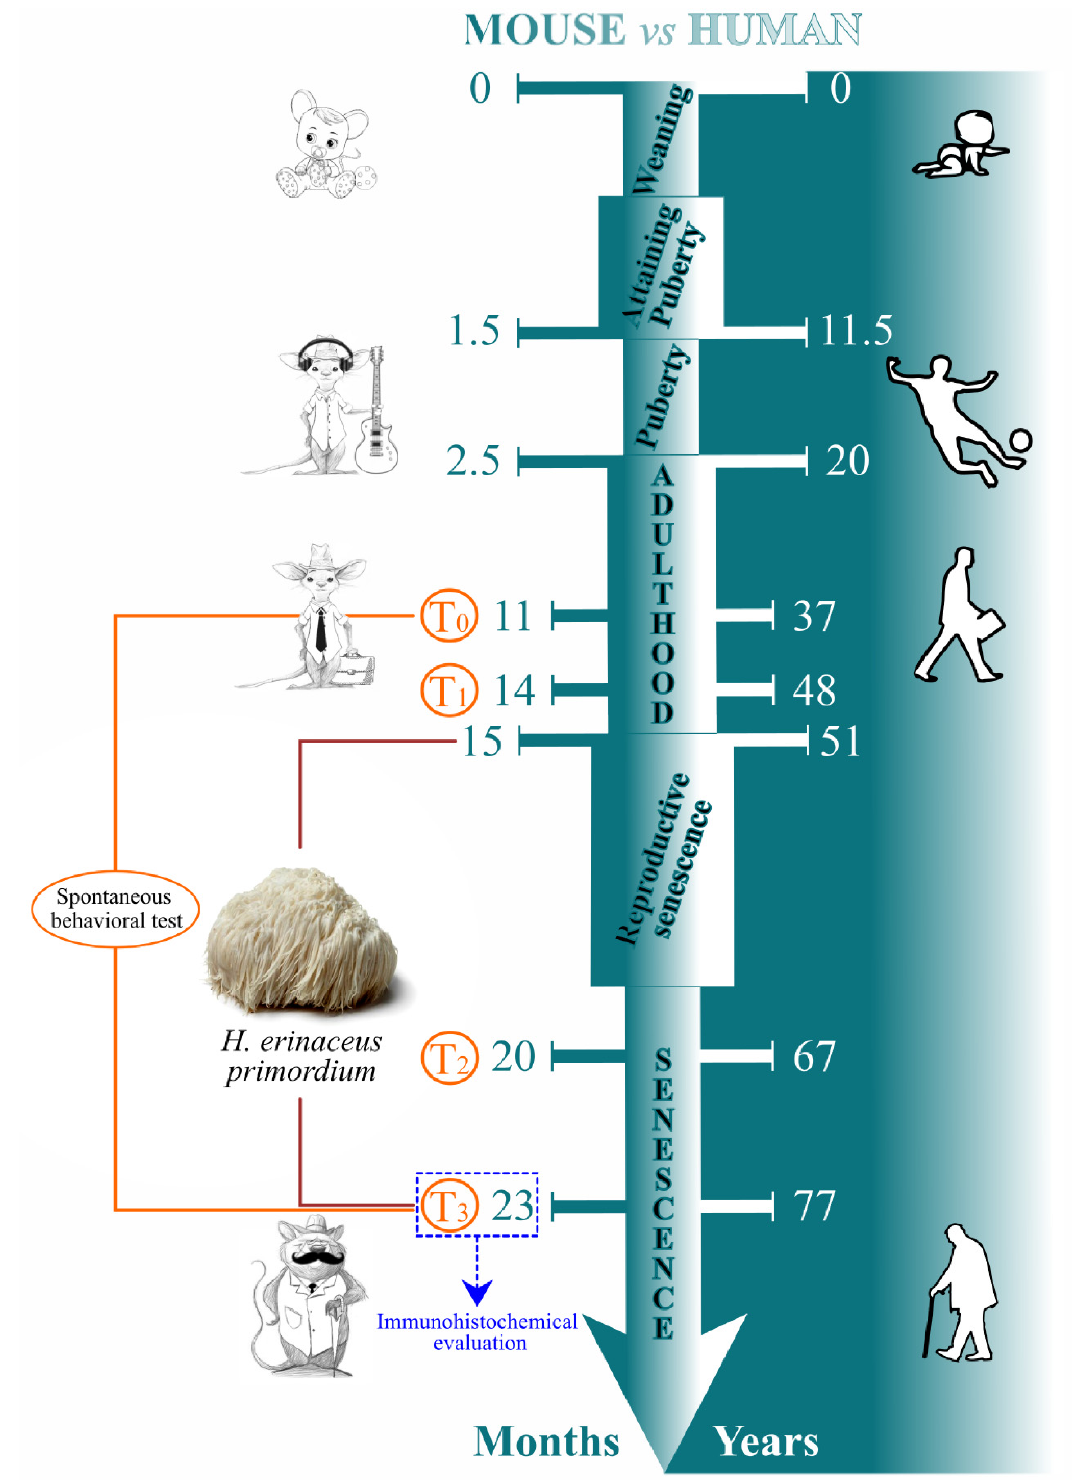
Figure 1. Schematic representation drawing experimental design (personalized from Dutta and Sengupta 2016, Ratto et al., 2019 [22,42]).